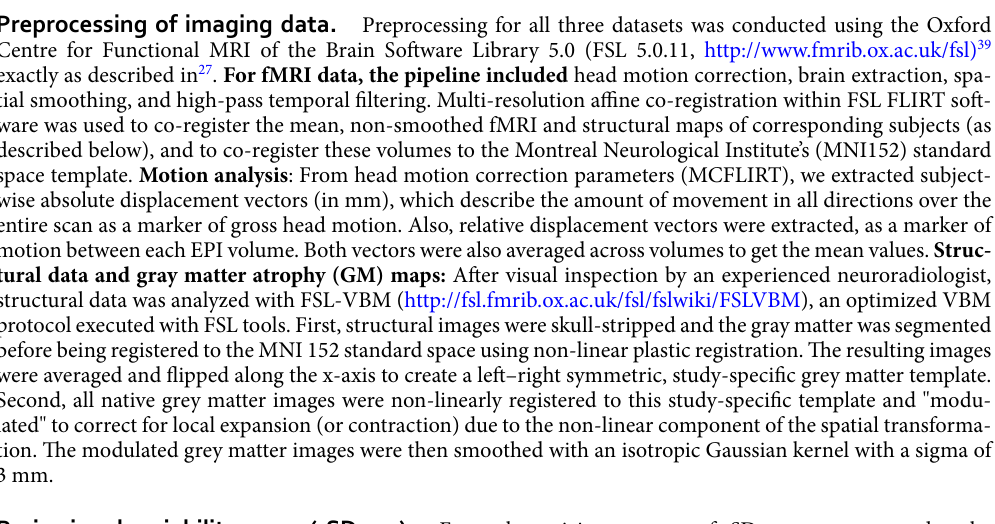
σ ( X BOLD ) µ ( X BOLD